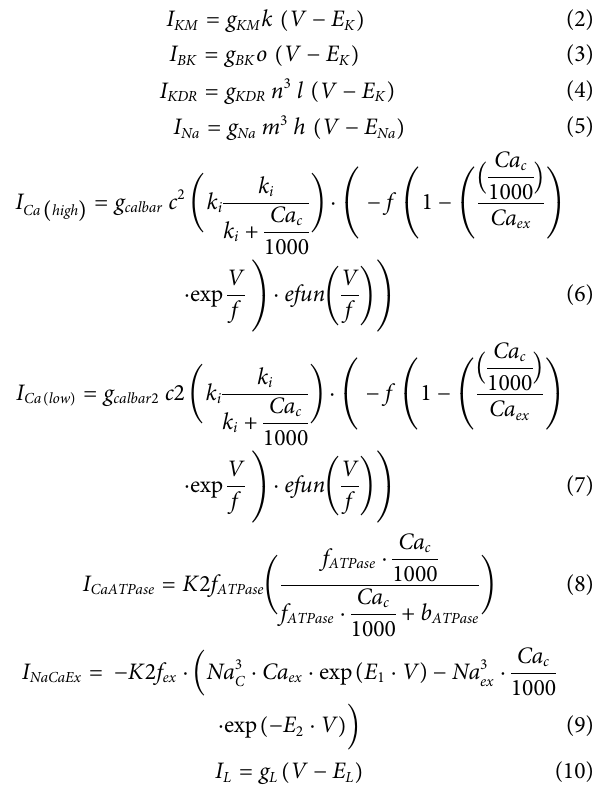
Frontiers in Pharmacology |